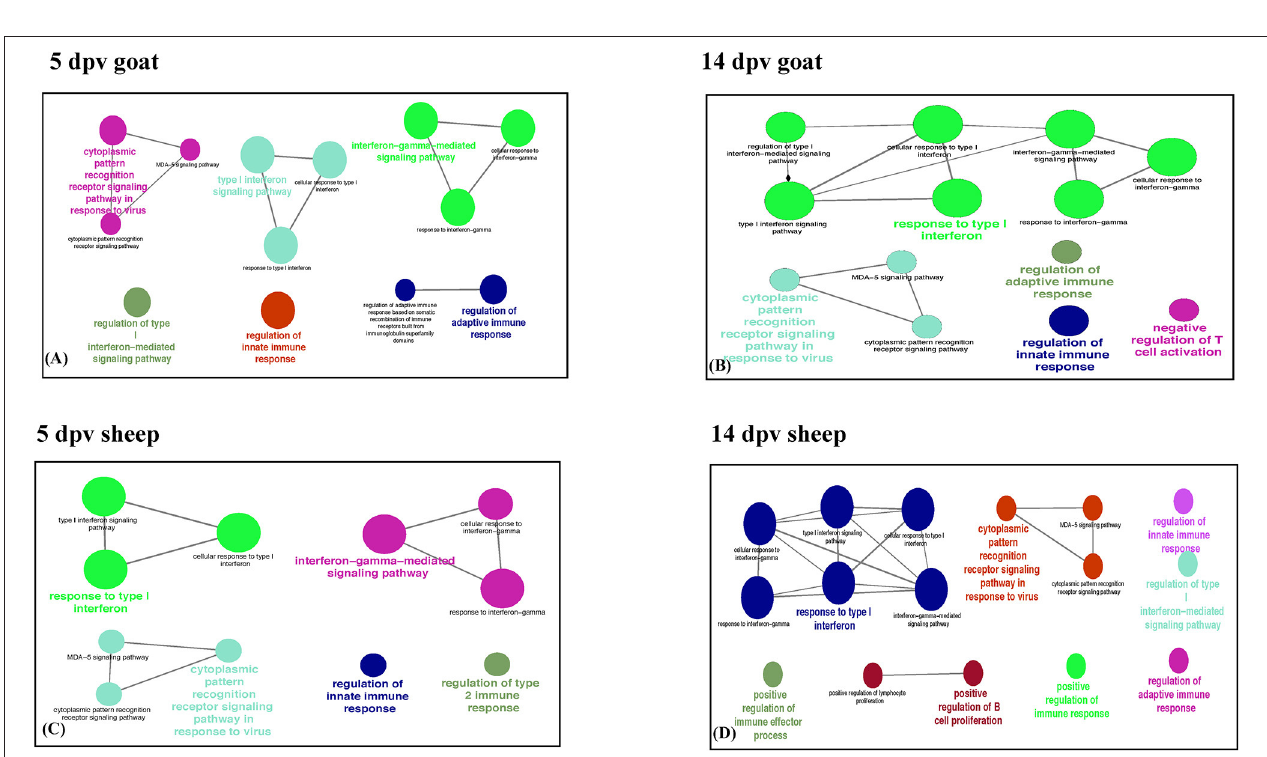
FIGURE 1 | (A) Differentially expressed proteins (DEPs) in vaccinated goats and sheep at 5 days post-vaccination (dpv) and 14 dpv. (B) DEPs in vaccinated goats and sheep at 5 and 14 dpv with cutoff fold change > 2 for upregulated and < 0.5 for downregulated proteins. (C) Venn diagram representing common and unique DEPs between sheep and goats at 5 and 14 dpv.